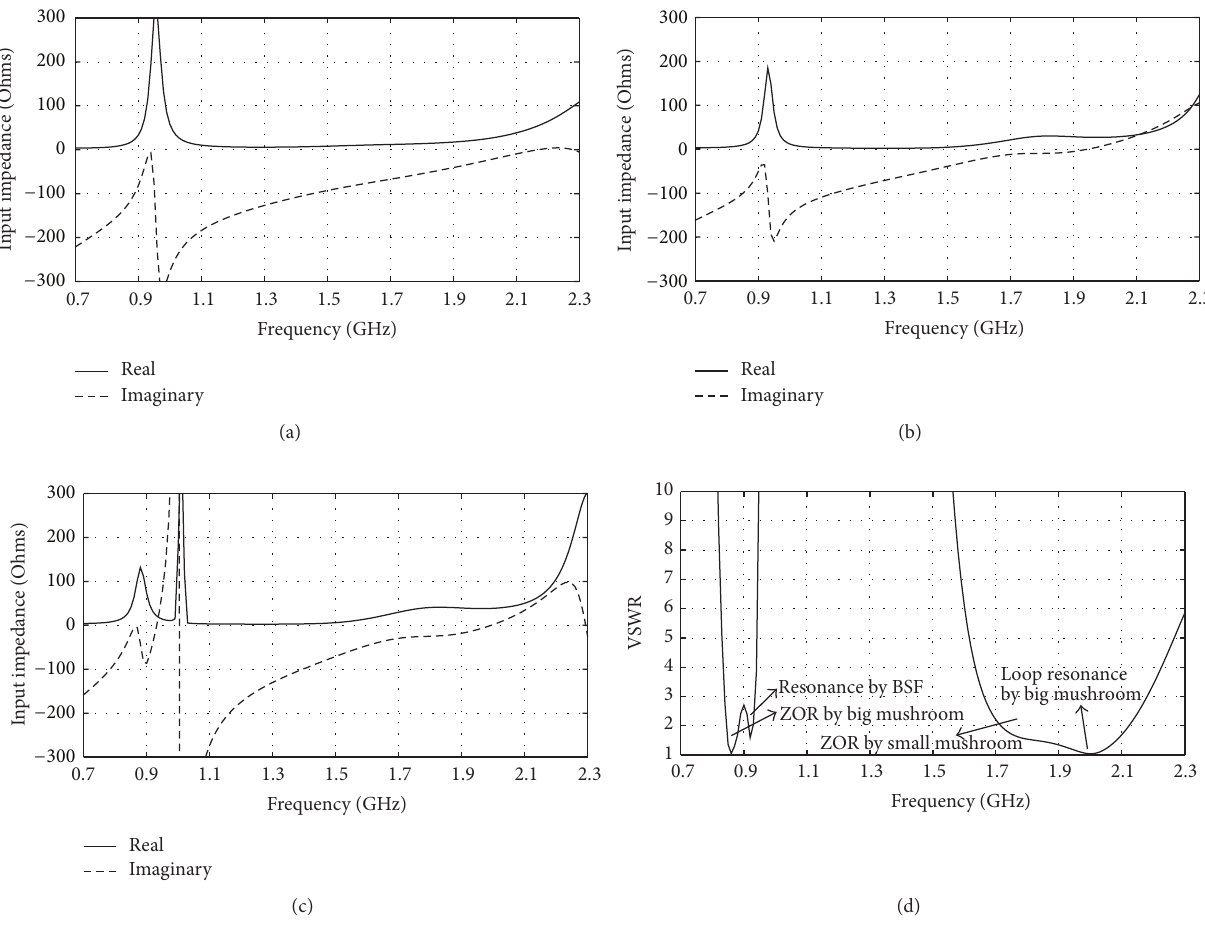
Figure 5: (a) Simulated input impedance of the single ZOR. (b) Simulated input impedance of the dual ZOR. (c) Simulated input impedance of the dual ZOR with BSF. (d) VSWR of the dual ZOR with